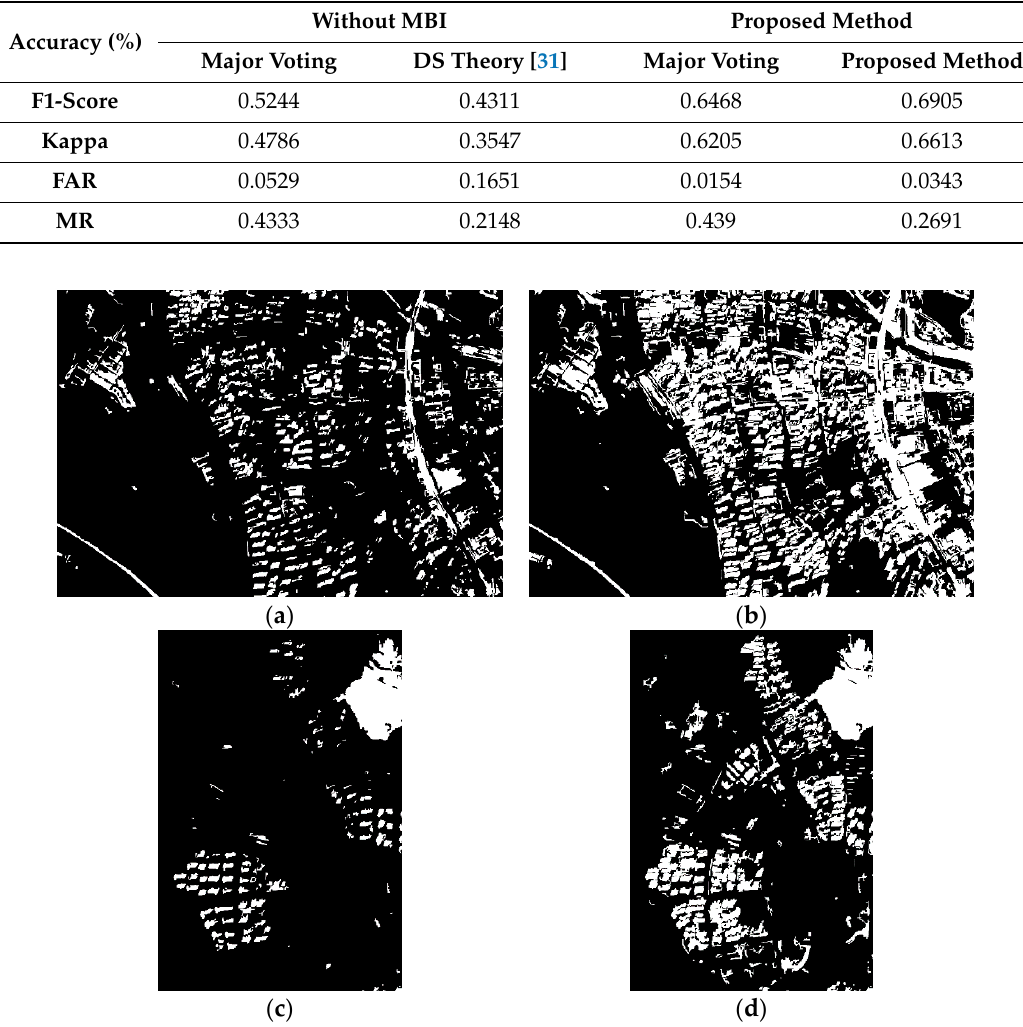
Figure 10. OBCD results without using MBI: ( a ) OBCD result of the first subset using major voting, ( b ) OBCD result of the first subset using D–S theory, ( c ) OBCD result of the second subset using major voting, and ( d ) OBCD result of the second subset using D–S theory.